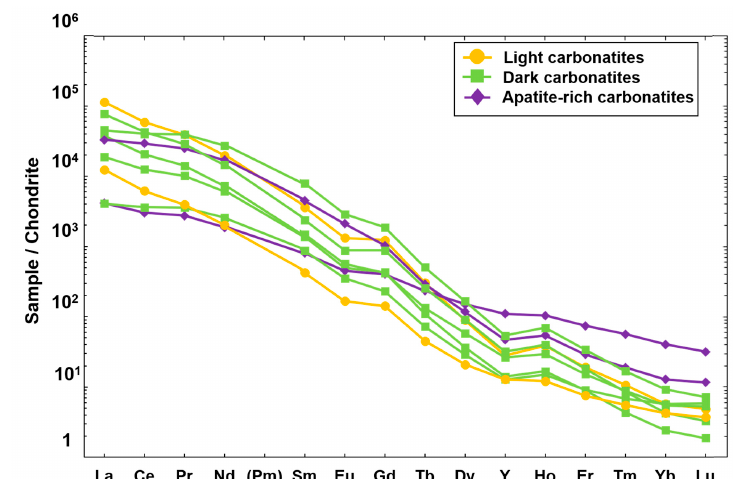
Figure 5. Chondrite-normalized REE patterns of the different types of carbonatites in the Kangankunde Carbonatite Complex. Normalization values from McDonough and Sun [36].